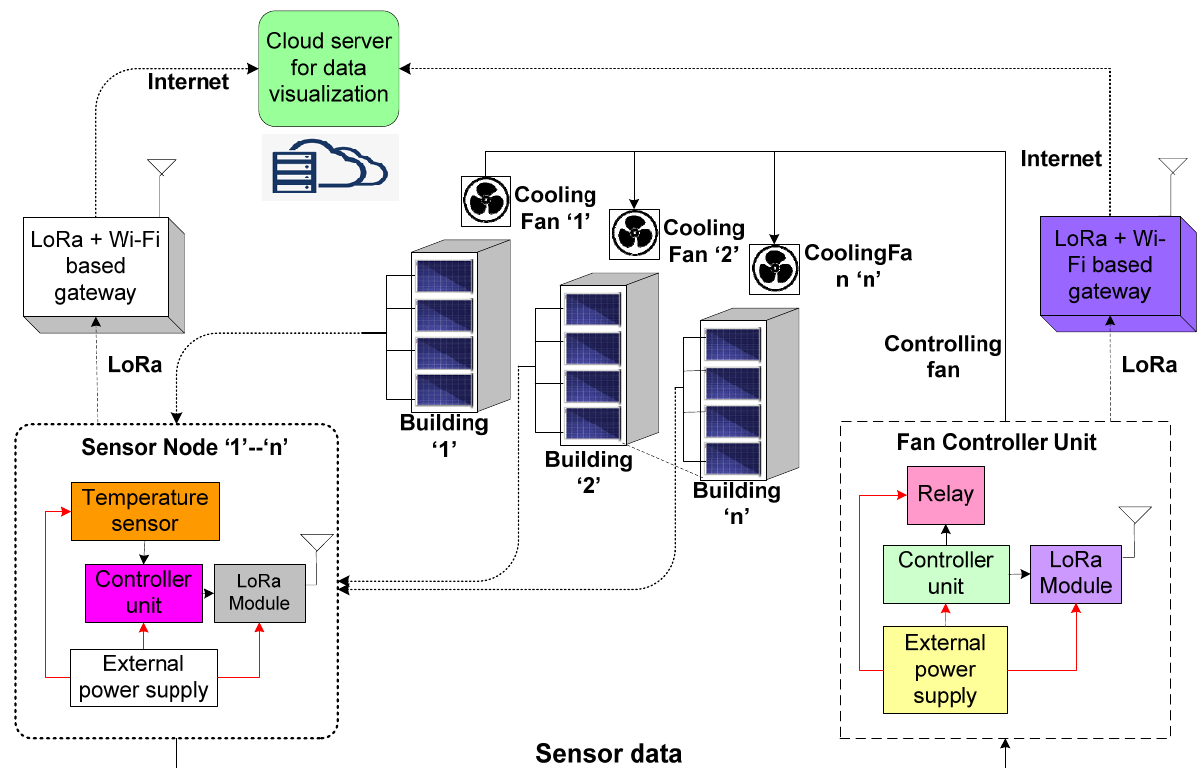
Figure 11. Proposed architecture for automatic fan cooling using IoT and LoRa.